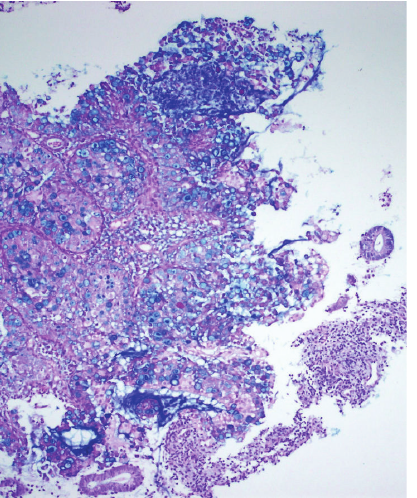
Figure7: Intracytoplasmic mucin depositionvisualized with Alcian